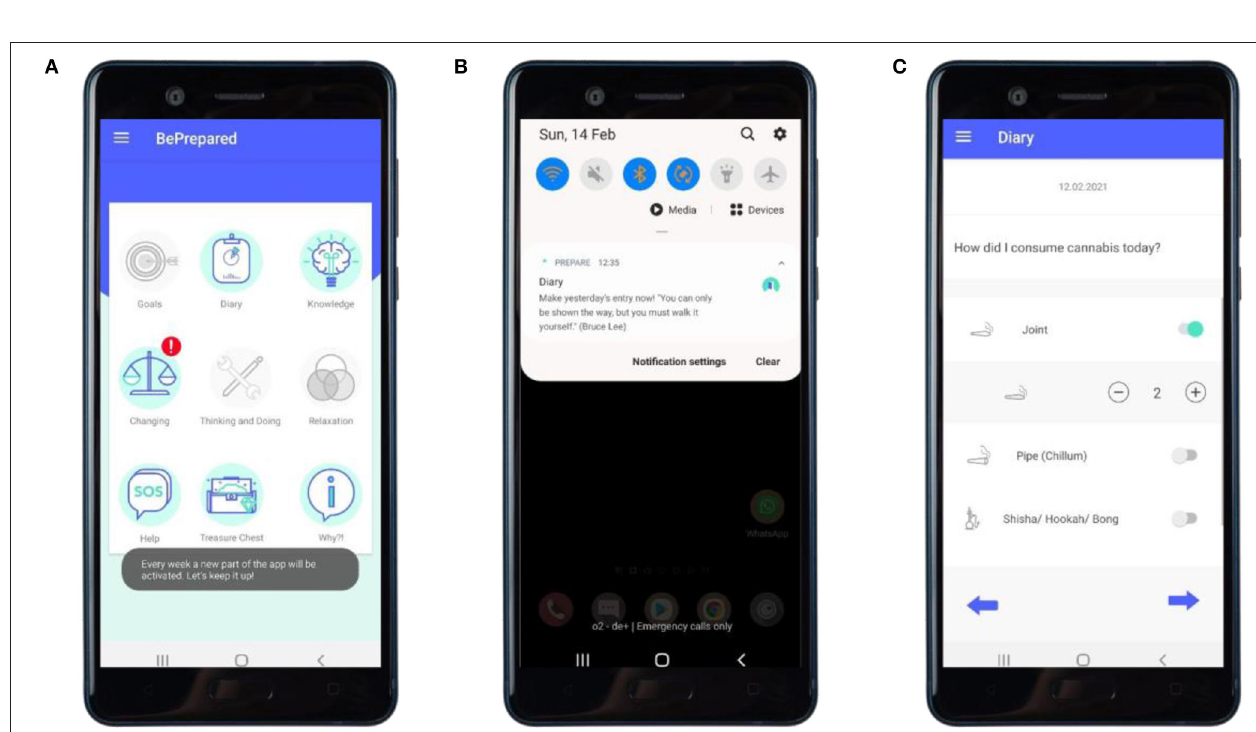
FIGURE 2 | “Diary”: self-monitoring and prompts. (A) Main screen of the app with newly activated modules highlighted by alert and an explanatory toast regarding not yet activated modules. (B) Encouraging prompt on the user’s home screen. (C) User making diary entry.